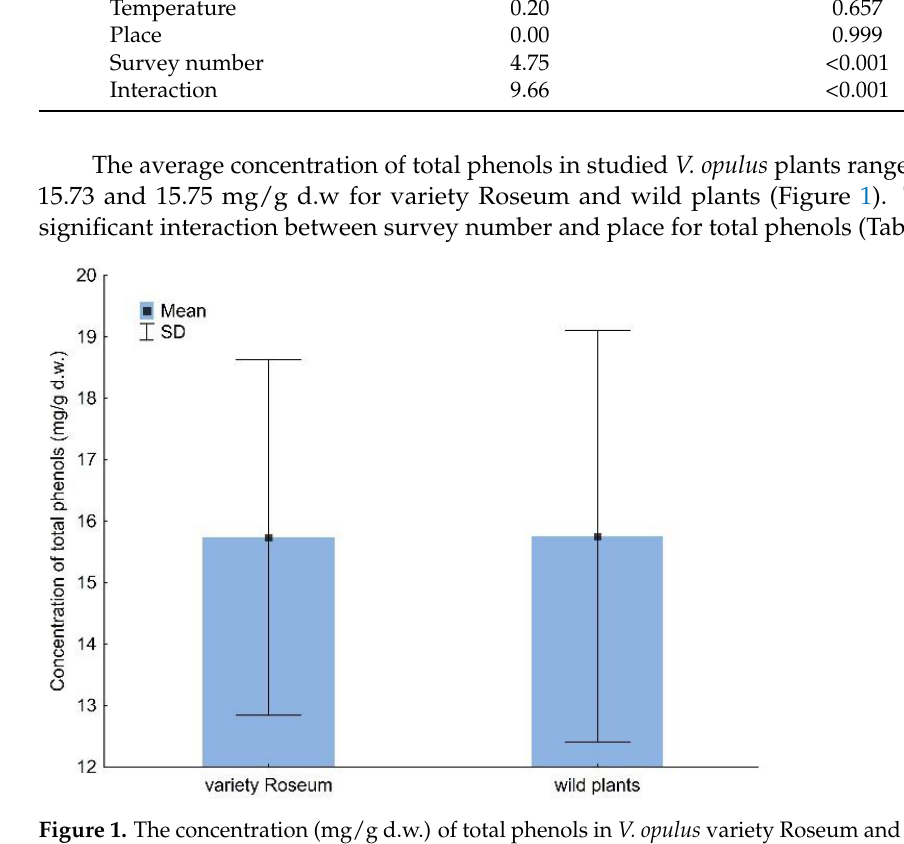
Figure 1. The concentration (mg/g d.w.) of total phenols in V. opulus variety Roseum and wild plants.